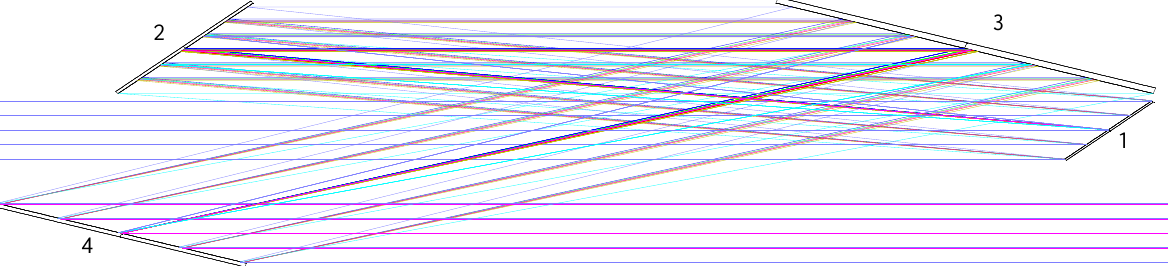
Fig. 2. Mixed-grating compressor layout with spatial chirp compensation. Thicknesses of the gratings are not to scale. Different colours represent the spectral width of 26nm.